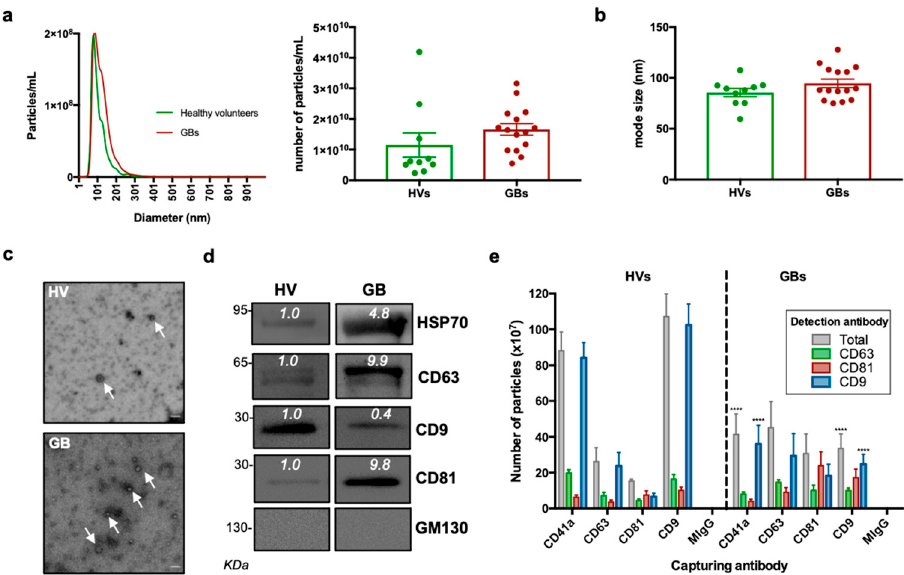
Figure 2. Characterisation of sEVs isolated from GB patients and healthy volunteers. ( a ) NTA of sEVs. The sEV suspensions from healthy volunteers (HV) ( n = 10) and GB patients ( n = 15) were diluted 1:50 and infused into a NanoSight NS300 instrument. Five captures of 60s each were recorded. Particle concentration (particles/mL) and size (nm) were measured. The mean number of particles/mL ± SEM is shown. ( b ) Mode size (nm) ± SEM of sEVs is shown (healthy volunteers = 10; GB patients = 15). ( c ) Representative electron microscopy images of GB patient- and healthy volunteer-derived sEVs; 30k magnification was used. White arrows show sEVs. Scale bar = 100nm. ( d ) Representative Western blots of GB patient- and healthy volunteer-derived sEVs, showing the presence of protein markers commonly associated with sEV subpopulations. The absence of the Golgi protein marker, GM130, indicates that non-EV cellular components were below the detection threshold. The same protein amounts of sEVs (10 µ g) were loaded per lane. ( e ). ExoView analysis of sEV markers. sEV samples were incubated on microarray chips coated with the indicated antibodies. CD9-, CD63- and CD81-positive particles were detected after probing with a cocktail of fluorescent tetraspanin antibodies using the ExoView R100 platform. Results are the average of 2 healthy volunteer- and 2 GB patient-derived samples. For each sample, three technical replicates were performed. All data were adjusted for the dilution of the sample onto the chip. **** p <